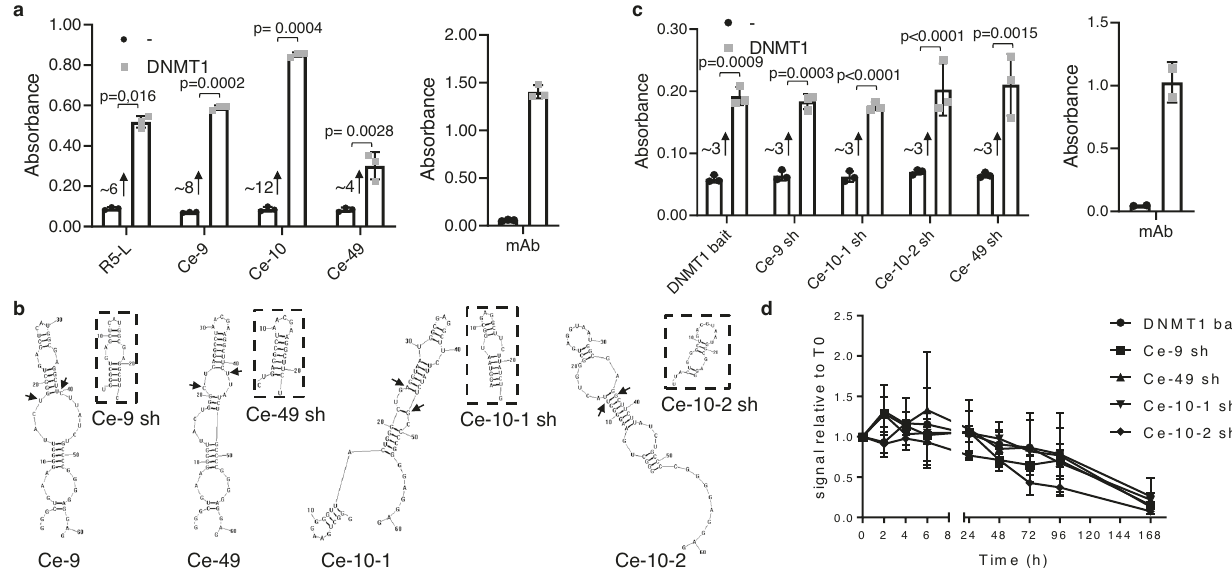
Fig.2|AnalysesandoptimizationofindividualaptamersfromSELEX.a Binding of biotinylatedselectedaptamersfrom SELEX and R5-L on DNMT1puri fi ed protein was analyzed by ELONA ( left panel ). Anti-DNMT1 antibody (mAb, right panel ) was used as a positive control. Error bars depict mean±SD. Experiment is representa- tive of three independent biological replicates. Statistics by two-tailed t -test is indicated ( n =3 biologically independent samples). Fold increase of binding is reported. b Predicted secondary structures of Ce-49, Ce-9 and Ce-10 and designed shortened aptamers (boxed). Two different folding and correspondent short aptamers were predicted for Ce-10 and indicated as Ce-10-1 and Ce-10-2, respec- tively. The black arrows indicate the sequences of the short versions within the corresponding long aptamer. c Binding of 3 ′ - biotinylated short aptamers and